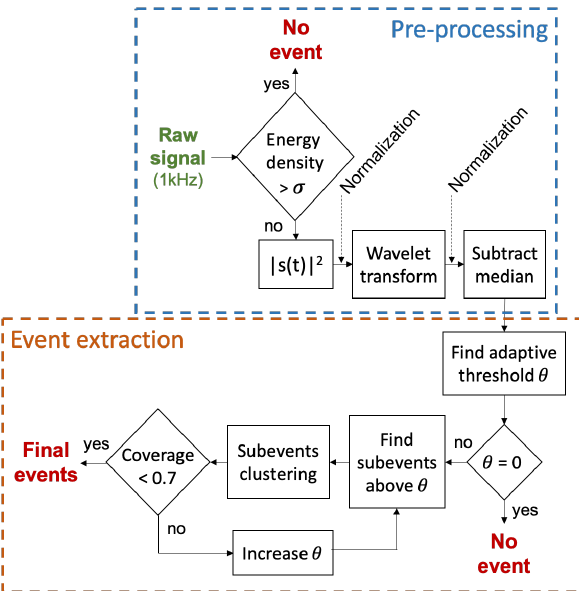
Figure 6. Diagram of the overall sound events detection